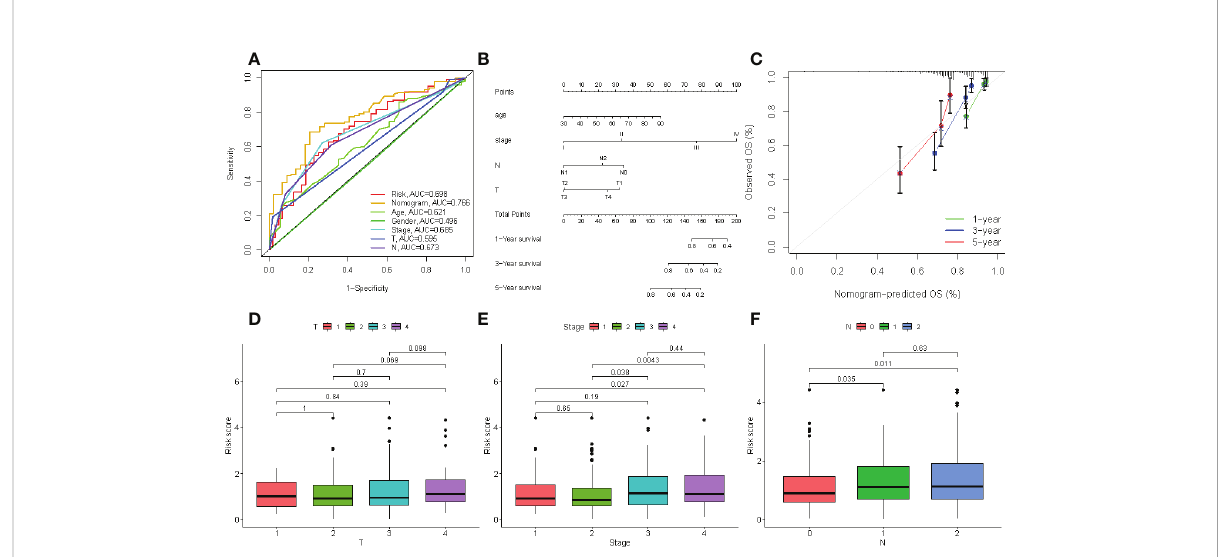
FIGURE 9 (A) Comparison of predictive performances of the four-gene signature prognostic risk model and other clinical characteristics. (B) The four- gene signature-based nomogram predicts 1-, 3-, and 5-year survival. (C) The calibration plot of the nomogram predicted and real surviving proportions. (D – F) The differences between riskscore and clinical